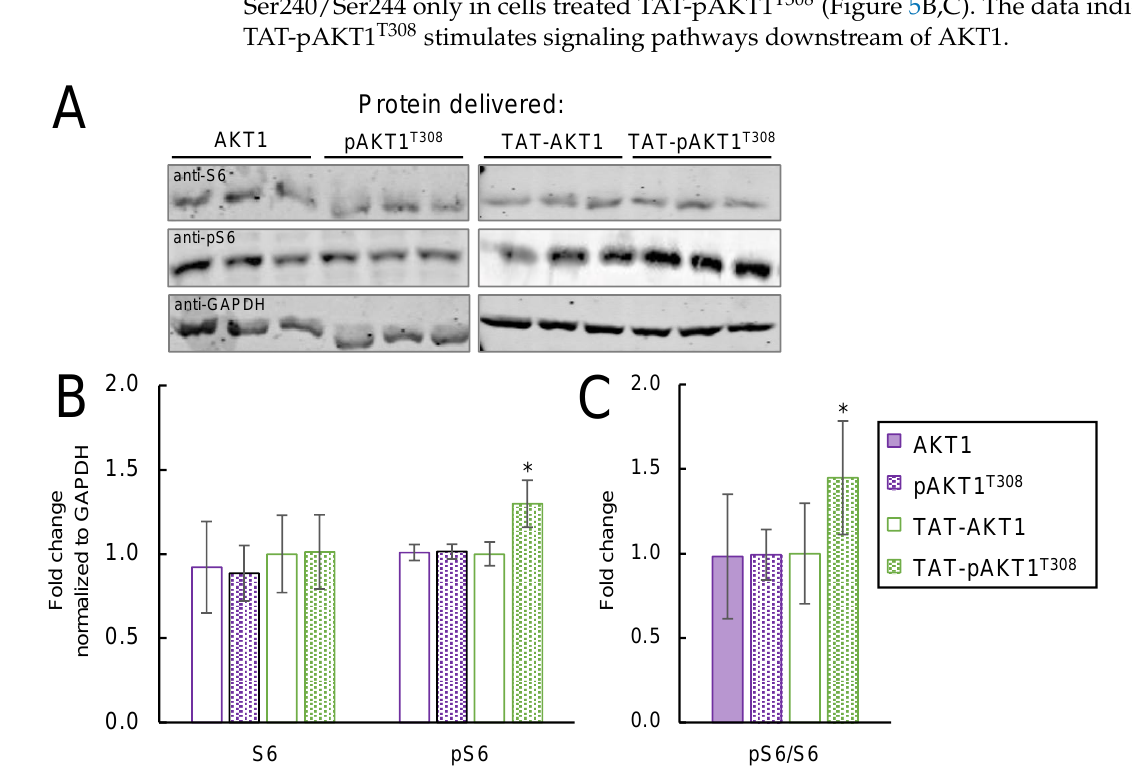
Figure 5. TAT-pAKT1 T308 protein delivery stimulates downstream AKT1 signaling to ribosomal protein S6. HEK 293T cells were incubated with AKT1, pAKT1 T308 , TAT-AKT1, and TAT-pAKT1 T308 for 1 h in three biological replicates. ( A ) Western blots and ( B , C ) quantification of blots of cell extracts separated by SDS-PAGE and immunoblotted with ribosomal protein S6, pS6, and GADPH specific antibodies. S6 phosphorylation was significantly increased after incubation with TAT-pAKT1 T308 , but not following incubation of cells with AKT1 or pAKT1 lacking the TAT tag or with unphosphorylated TAT-AKT protein variants. Significant differences were calculated by two-tailed t-test and are indicated by asterisks (* p < 0.05).